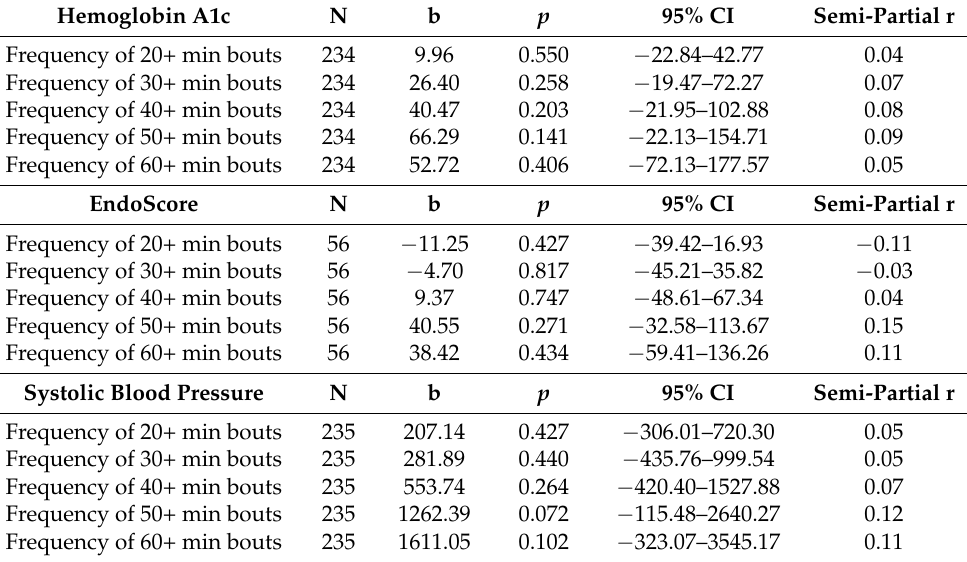
Table 3. Regression Coefficients for Frequency of Uninterrupted Sitting Bouts and Physiological Markers, Controlling for Physical Activity.